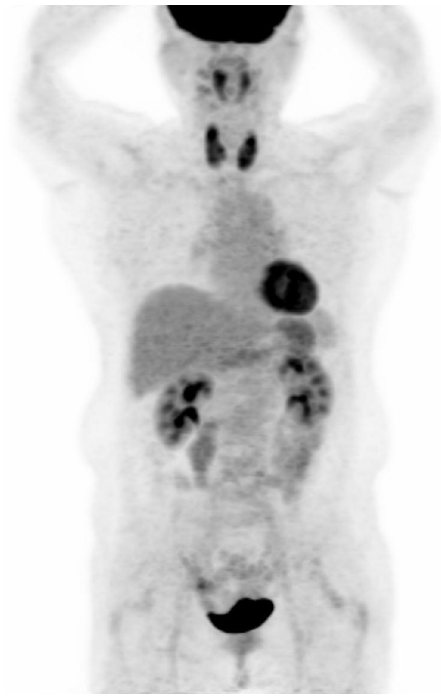
Figure 2. Visualization of both thyroid lobes in three-dimensional maximum-intensity-projection (MIP) images which was used as a criterion for diffuse thyroid uptake.